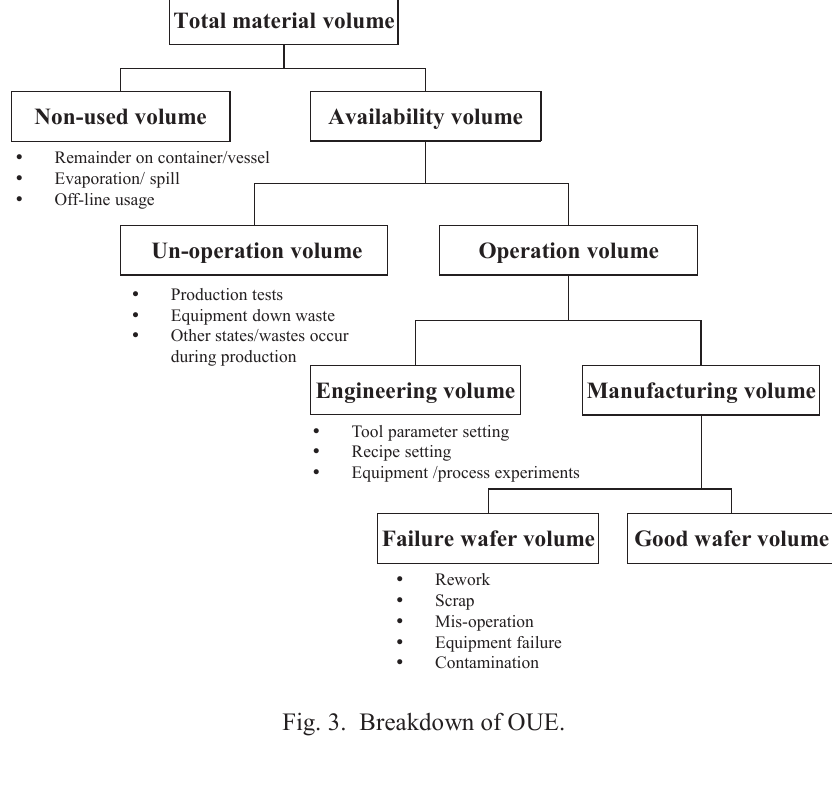
Fig. 3. Breakdown of